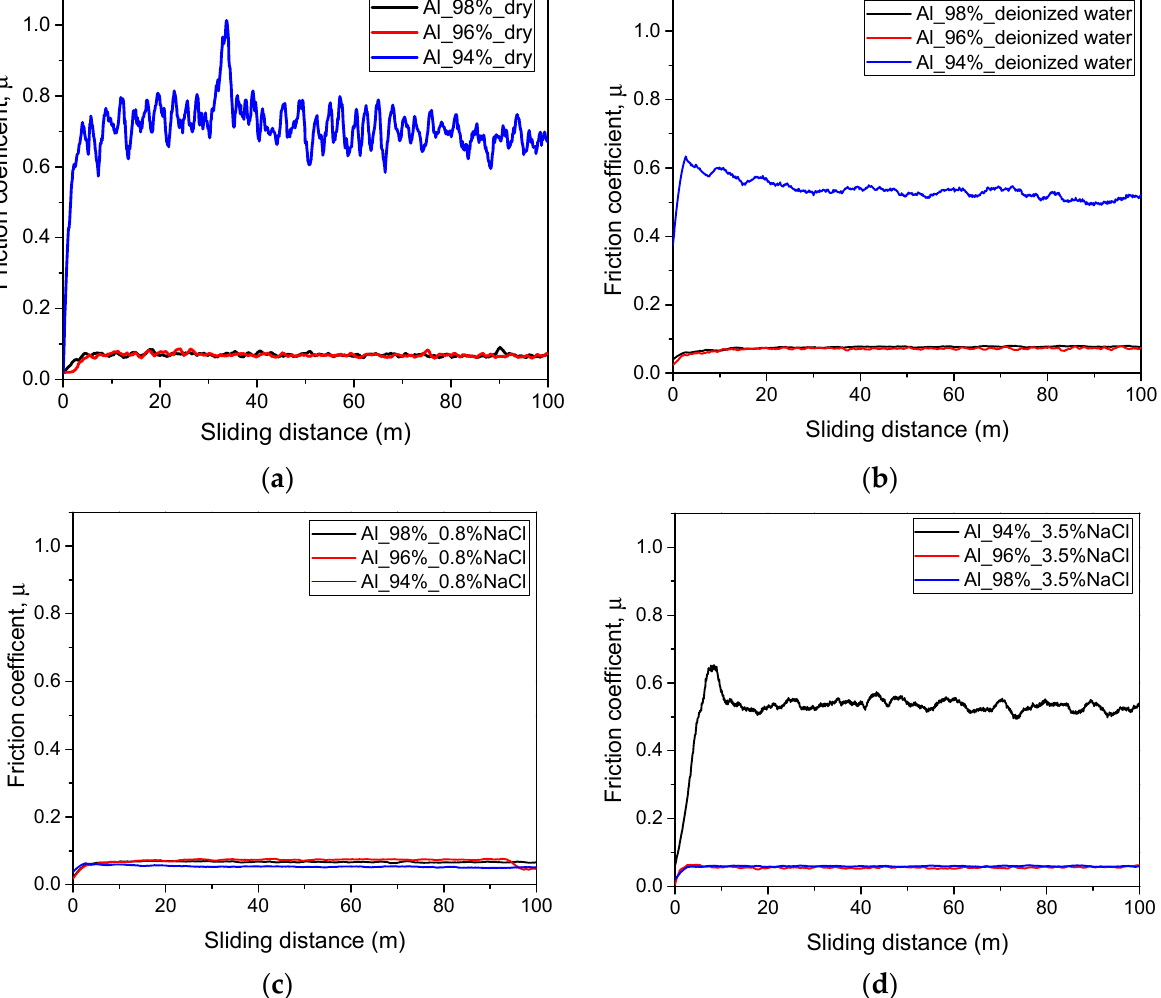
Figure 9. Evolution of the friction coefficient (µ) vs. sliding distance. (a) dry condition, (b) deionized water, (c) 0.8 % NaCl, and (d) 3.5 % NaCl.